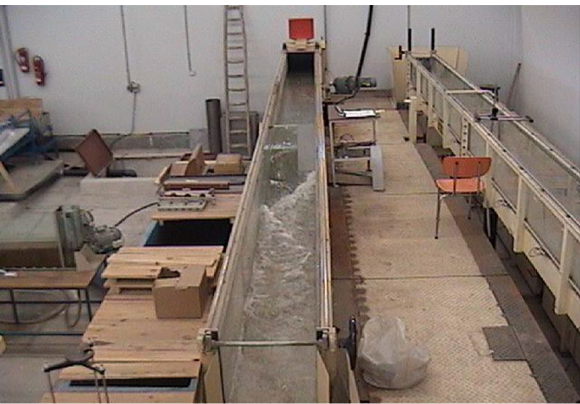
Fig. 5 Developments of stationary and oblique shocks in downstream of barrier